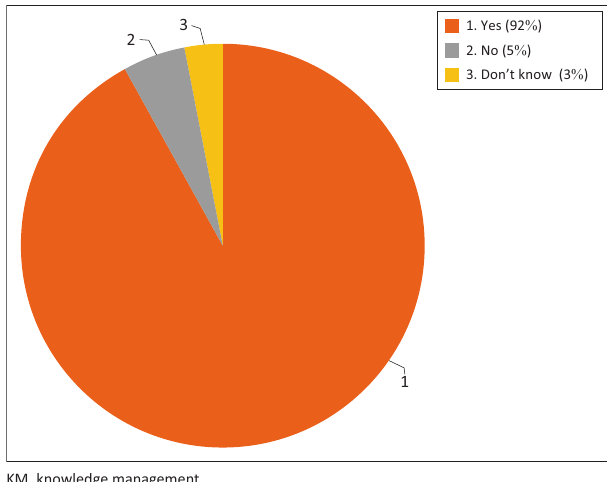
FIGURE 5: Respondents support for a knowledge management initiative ( N =